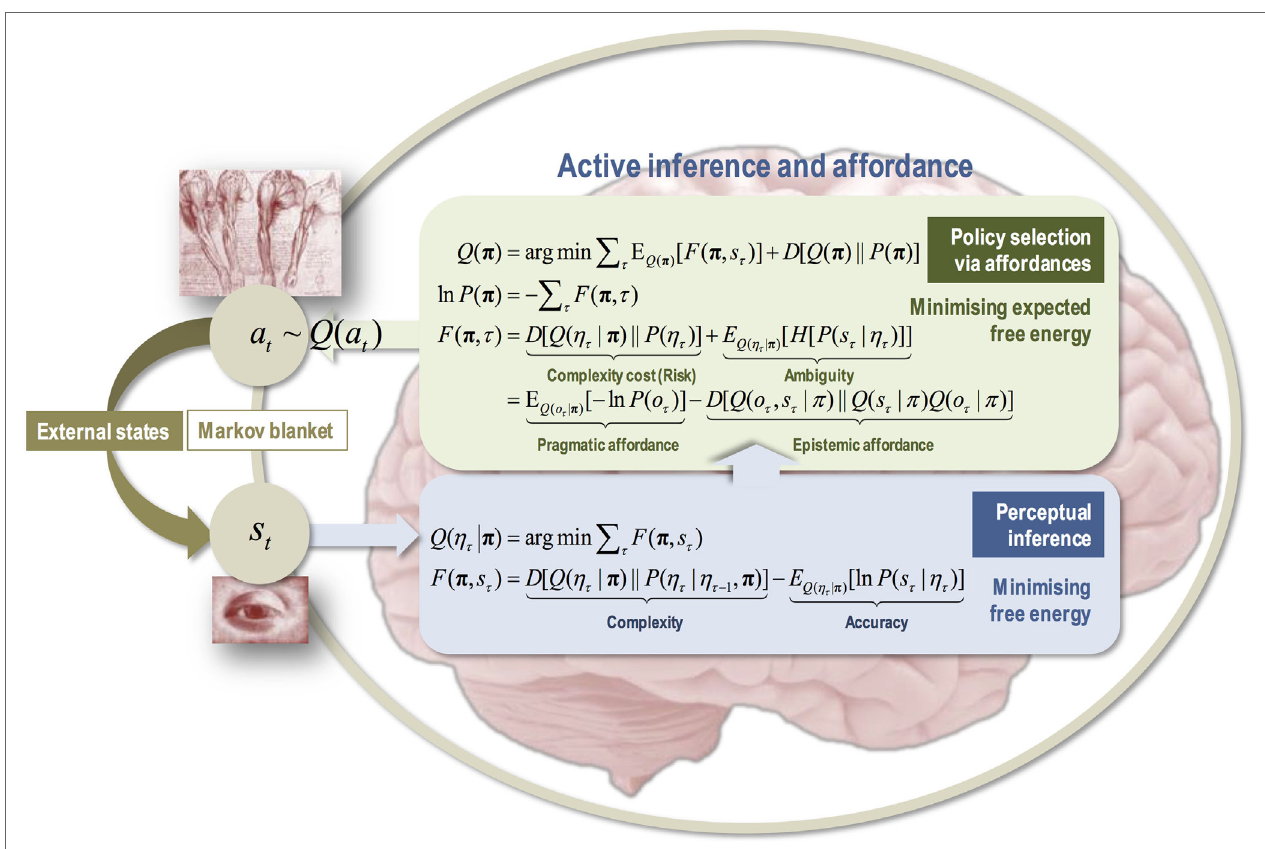
FiGUre 1 | Bayesian mechanics and active inference. This schematic summarizes the formal aspects of active inference in terms of minimizing variational free energy. It describes a generic (active) inference scheme that has been used in a wide variety of applications and simulations; ranging from games in behavioral economics (FitzGerald et al., 2015) and reinforcement learning (Schwartenbeck et al., 2015) through to language (Friston et al., 2017c) and scene construction (Mirza et al., 2016). The details of this scheme are not essential to understand the arguments in the main text: they are presented here for interested readers, with a special focus on how affordance emerges from minimizing (expected) free energy, under a generative model of the world. In this setup, discrete actions solicit a sensory outcome ( s ) that informs approximate posterior beliefs about external or hidden states of the world ( η ). This Bayesian belief updating can be described as minimizing variational free energy F ( π , s ) under a set of plausible policies ( π ). Here, a policy comprises a sequence of actions ( a ). The approximate posterior beliefs are then used to evaluate expected free energy F ( π , τ ) and subsequent beliefs about action; namely the affordances that underwrite policy selection. In other words, affordance corresponds to inference about action, where the most likely policy (to be selected) is the policy that minimizes expected free energy in the future. Q( η | π ) denotes beliefs about hidden states in the future, given a particular policy and Q( π ) are posterior beliefs about the policies currently being pursued. Free energy is just the difference between complexity and accuracy . In other words, an approximate posterior with a low free energy provides an accurate but simple explanation for sensory input. Expected free energy can be similarly decomposed into expected complexity (i.e., complexity cost or risk ) and expected inaccuracy (i.e., ambiguity ). Complexity can be regarded as the divergence (denoted by the Kullback–Leibler divergence D ) between what one expects to happen under a particular policy and what one would prefer a priori . Ambiguity is the loss of a precise or definitive mapping between external states of the world and observed sensory